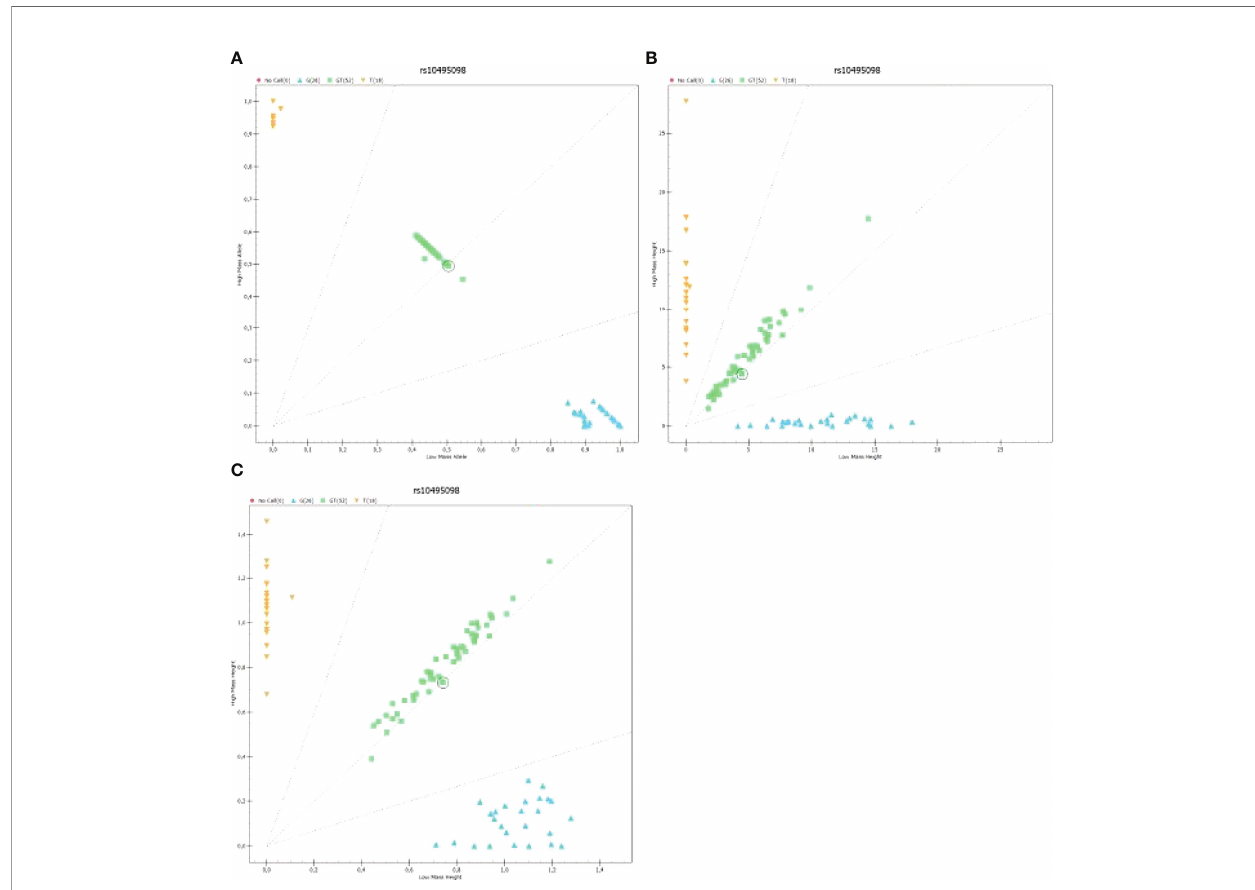
FIGURE 2 | The graph presenting the distribution of homo- and heterozygotes for polymorphism rs10495098 for all samples analyzed on a 96-well plate: (A) The graph presenting the distribution of low-mass C homozygote (Low Mass Allele) to high-mass A homozygotes depending on the yield; (B) The graph presenting the heights of peaks being signals of mass spectra for homo- and heterozygotes; (C) The graph presenting the logarithmic value of signal intensity of mass spectra for homo- and heterozygotes [Log [Height]). .